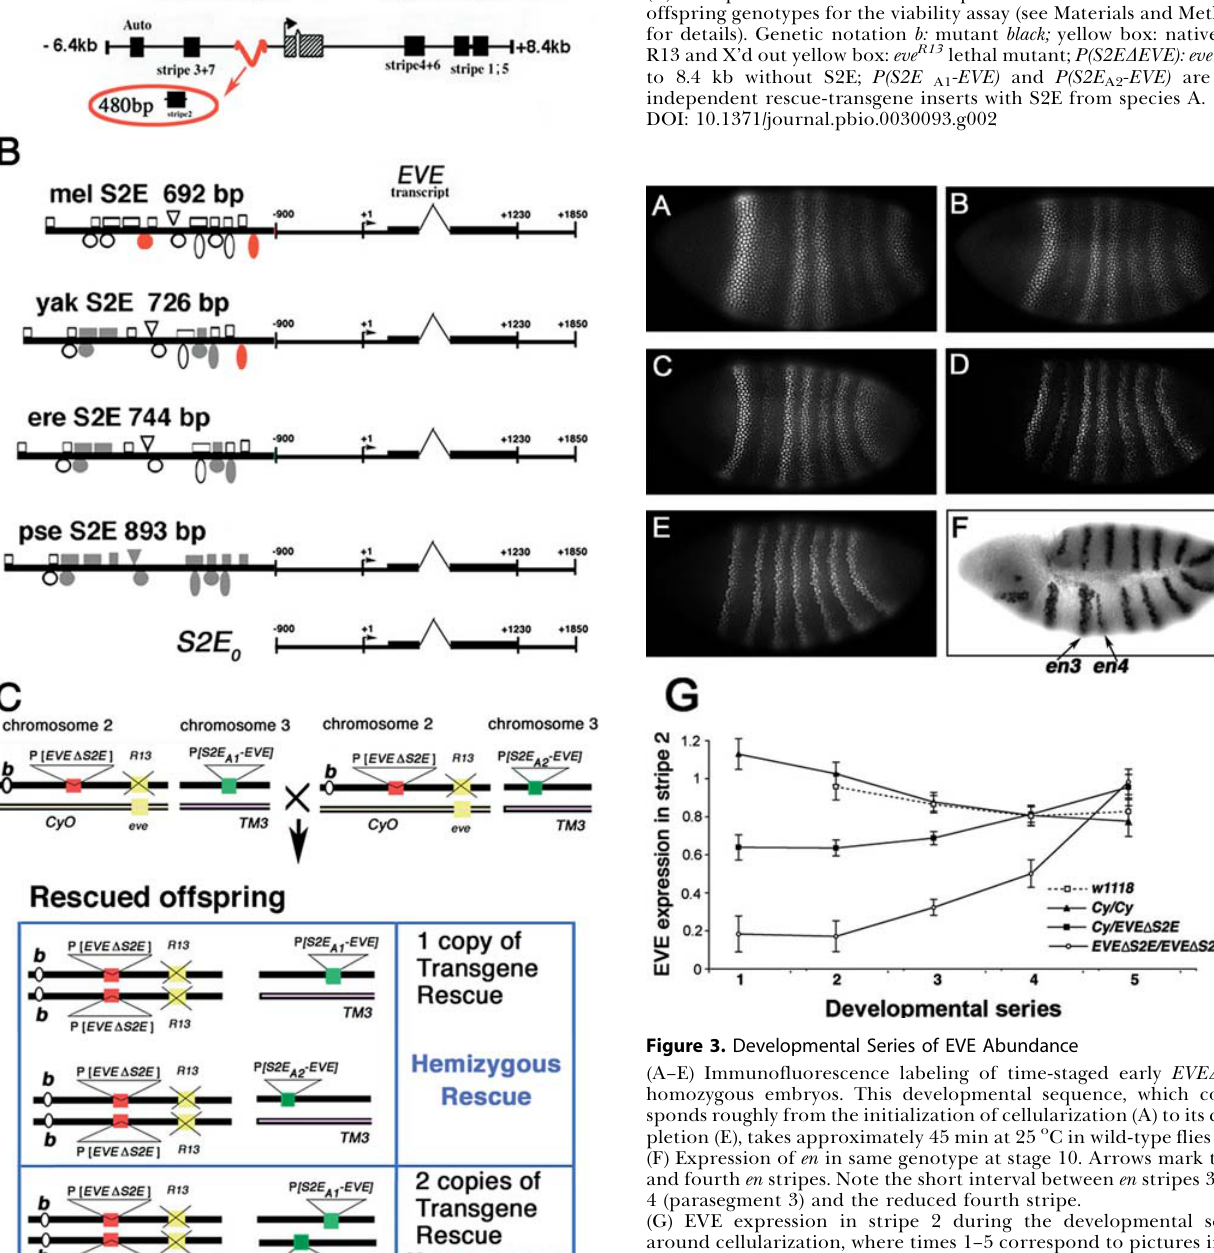
bicoid (circles), three hunchback (ovals), six Kruppel (squares), three giant (rectangles), and one sloppy-paired (triangle) binding site. Symbols representing sites 100% conserved compared to D. melanogaster are open, while those diverged are shaded gray. Note the evolutionary gain of novel but functionally necessary [6] activator (bicoid and hunchback) binding sites (red) in D. melanogaster lineage. Full sequences are shown in Figures S1 and S2. (C) Example of a cross between independent rescue lines and relevant offspring genotypes for the viability assay (see Materials and Methods for details). Genetic notation b: mutant black; yellow box: native eve; R13 and X’d out yellow box: eve R13 lethal mutant; P(S2E D EVE): eve (cid:1) 6.4 to 8.4 kb without S2E; P(S2E A1 -EVE) and P(S2E A2 -EVE) are two